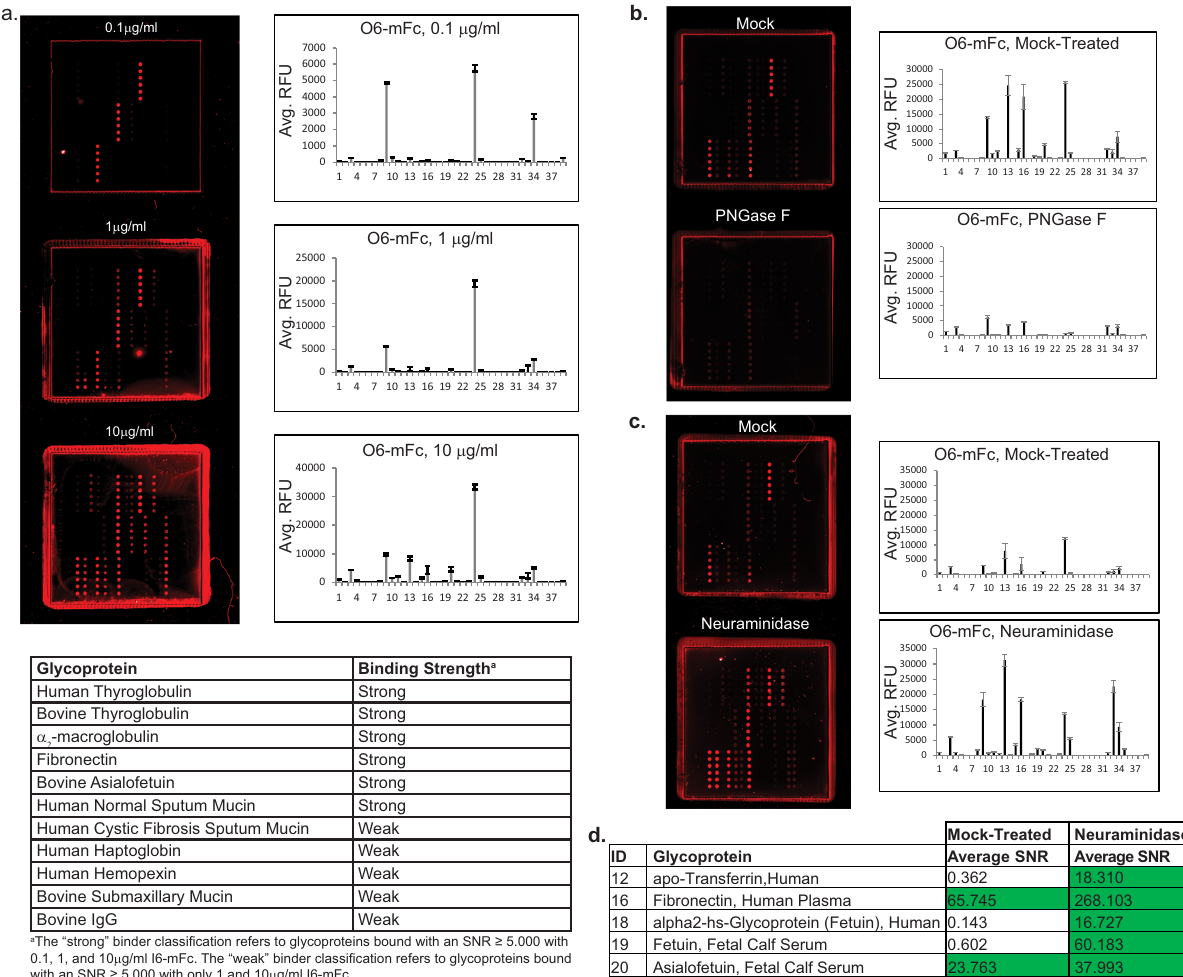
Weak a The “strong” binder classifi cation refers to glycoproteins bound with an SNR ≥ 5.000 with 0.1, 1, and 10 (cid:4) g/ml I6-mFc. The “weak” binder classifi cation refers to glycoproteins bound with an SNR ≥ 5.000 with only 1 and 10 (cid:4) g/ml Fig. 4 Development of a new glycoprotein microarray reveals many human serum glycoproteins carrying galactose-3-sulfate modi fi cation. a Binding of O6-mFc on the glycoprotein array at three different concentrations, with the actual slide image shown and the plot of binding, RFU relative fl uorescence units, error bars = ±1 SD. b PNGaseF treatment of the glycoprotein array eliminates many positive binders, suggesting that galactose-3-sulfate modi fi cations are carried on N-glycans. c Treatment of the glycoprotein array with neuraminidase reveals many more positive binders and are summarized in the table d ) below the